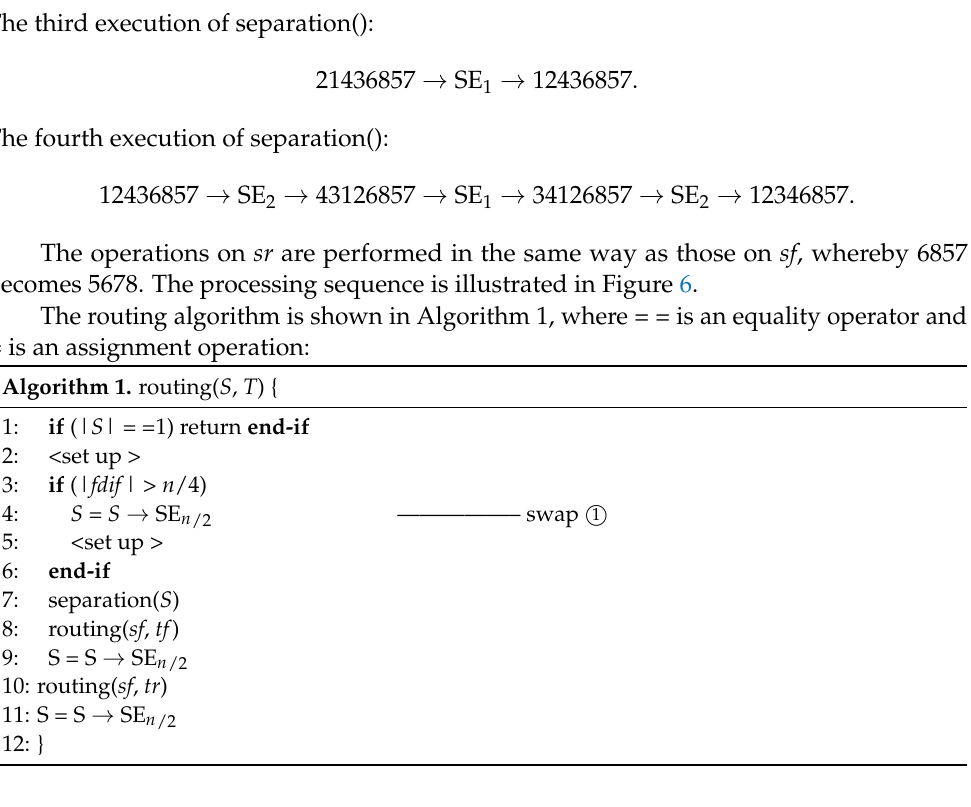
Algorithm 1. routing( S , T ) {